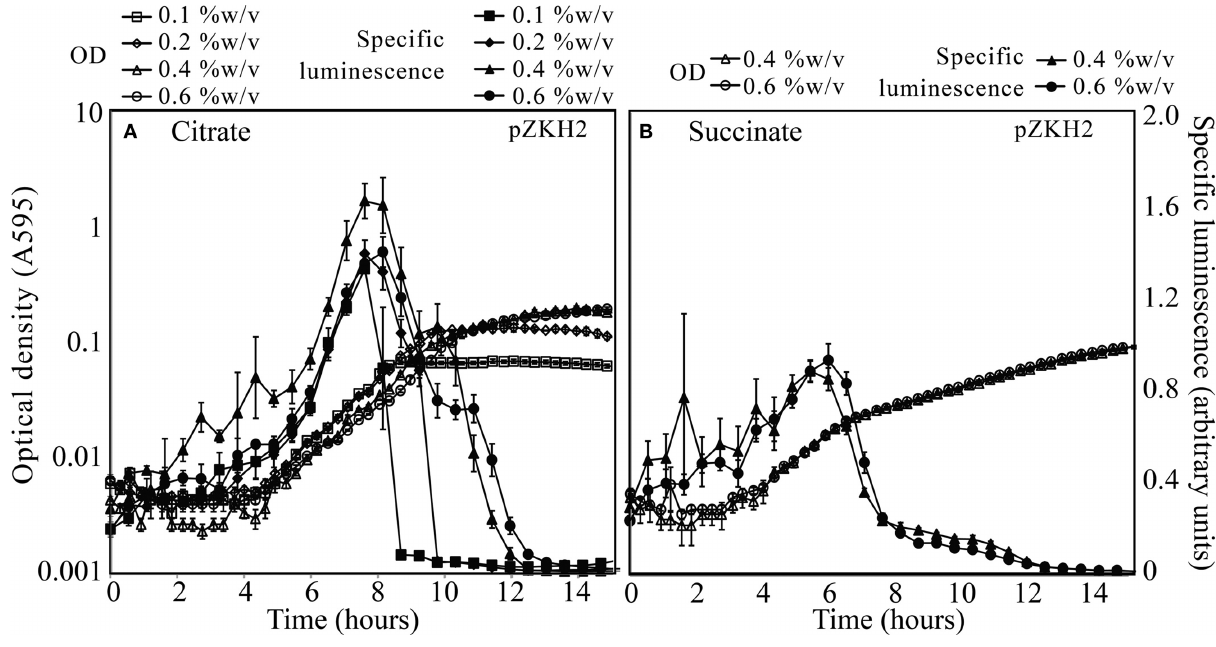
were inoculated into M9 medium with citrate at one of four concentrations (%w/v) or succinate at one of two concentrations (%w/v). All values are mean ±